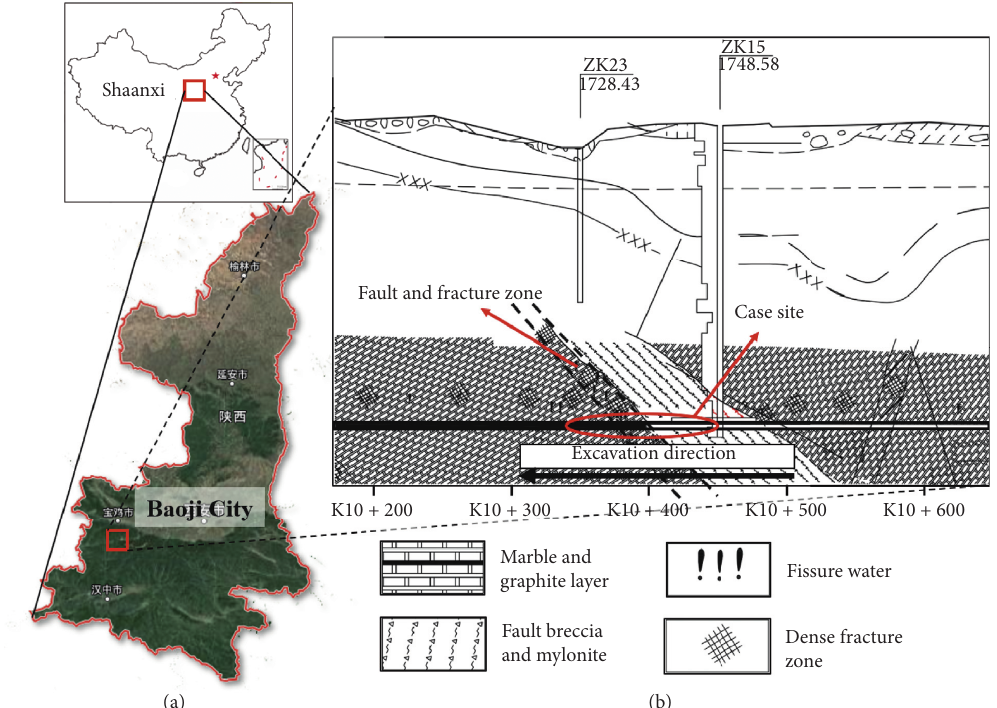
Figure 1: Schematic diagram of case area location. (a) Location of case project. (b) Geological section map for the case area